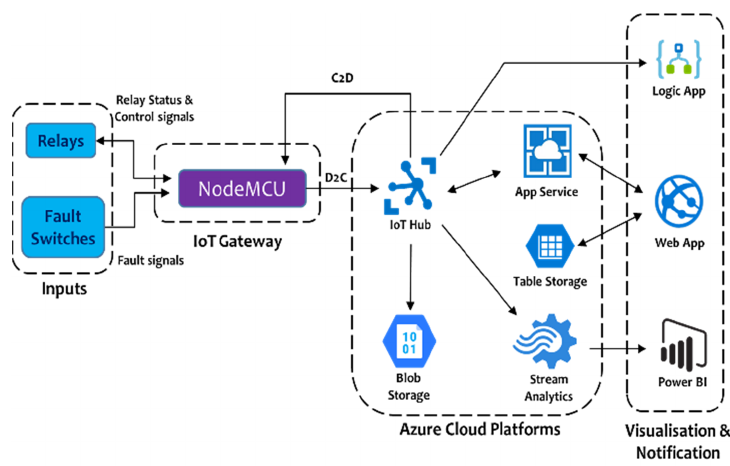
Figure 5. The proposed system architecture.